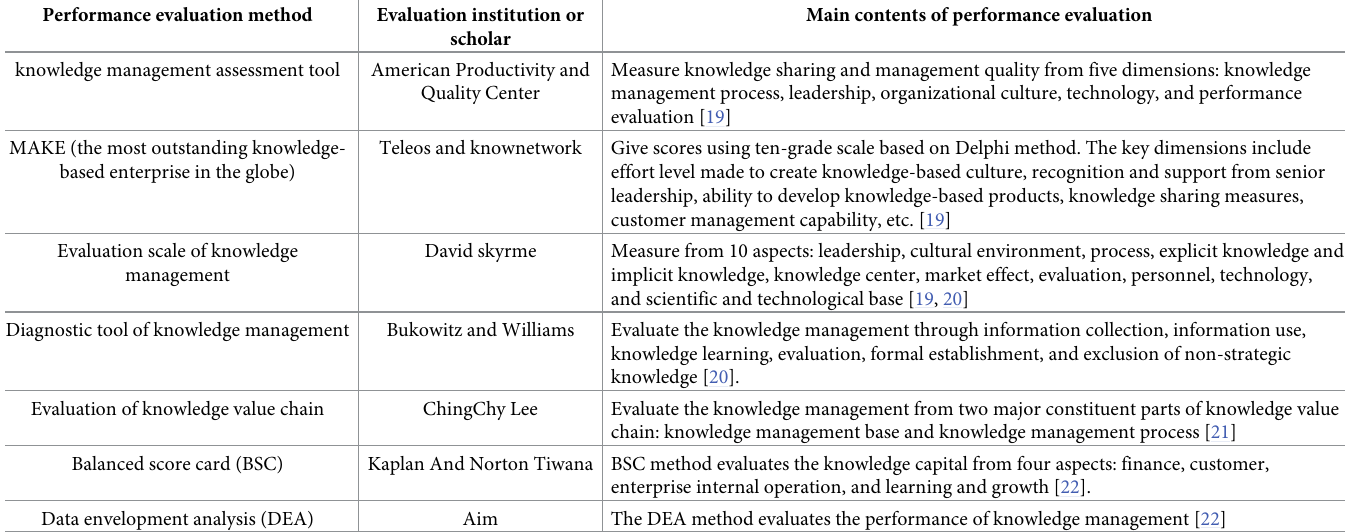
Table 1. Evaluation method and content of knowledge